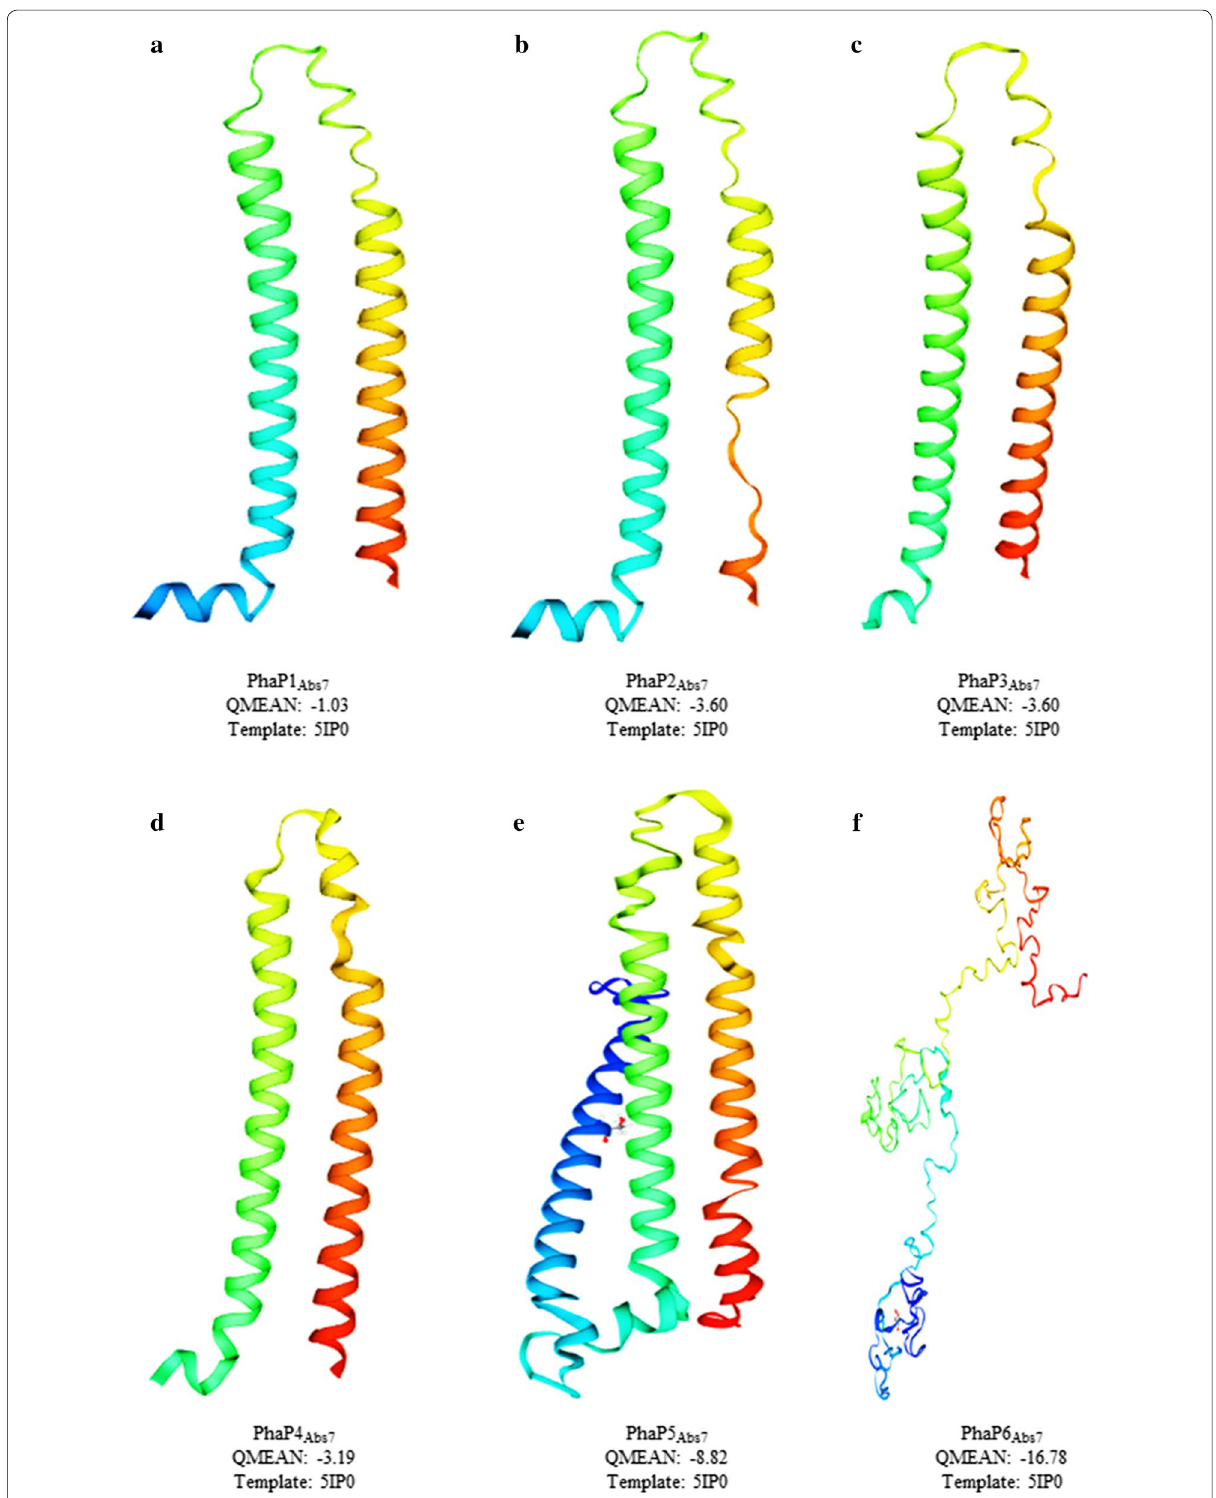
Fig. 2 Predicted three‑dimensional structures of A. brasilense Sp7 phasins. Structures were predicted using the I‑TASSER and SWISS‑MODEL servers. The crystal structure of PhaP from A. hydrophila (PDB number 5IP0) was used as template. For each A. brasilense Sp7 phasin, the QMEAN value was calculated and the Ramachandran plots were obtained (see Additional file 3). a PhaP1 Abs , b PhaP2 Abs , c PhaP3 Abs , d PhaP4 Abs , e PhaP5 Abs and f PhaP6